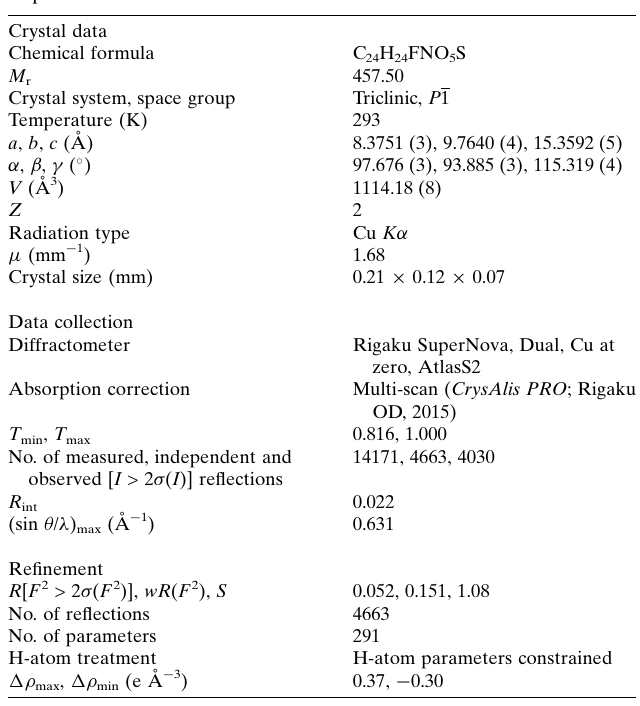
Figure 1 Structure–activity relationships of thiochroman-4-one